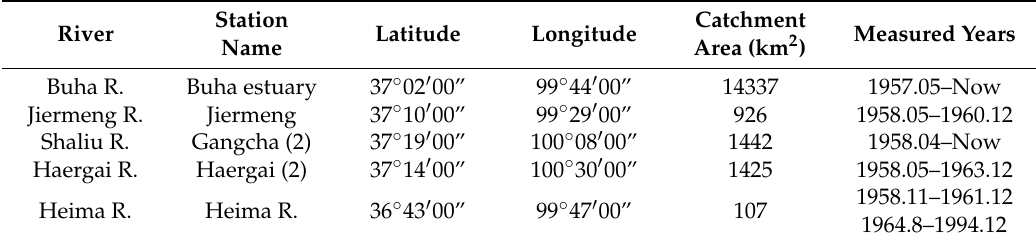
Table 3. Hydrological stations in Qinghai Lake